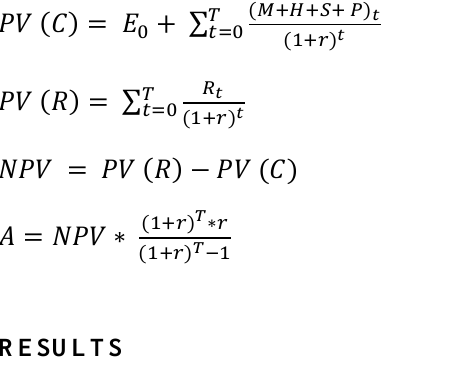
Figure 3. Costs of establishing a Sphagnum farming pilot site on former bog grassland in 2011 (2 ha of Sphagnum production fields) (cf. Wichmann et al. 2017) and of the extension to 5.6 ha in 2016 (cf. Table